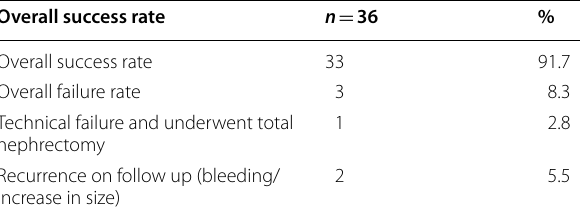
Table 4 Outcomes, follow‑up and changes in tumor sizes